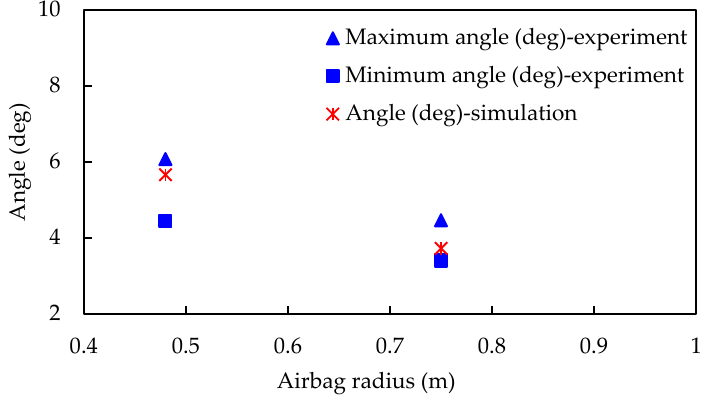
Figure 21. Effects of the airbag radius on the angular response of the platform.